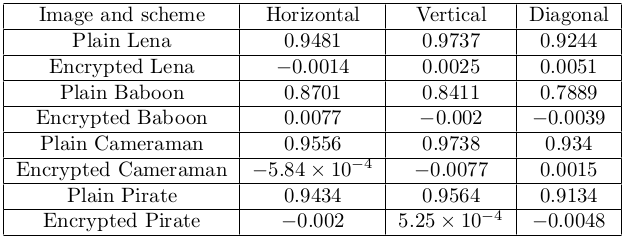
Table from the paper: An Image Encryption Algorithm Based on Chaotic Maps and Discrete Linear Chirp Transform
Table text:
Imageandscheme
Horizontal
Vertical
Diagonal
PlainLena
0.9481
0.9737
0.9244
EncryptedLena
− 0.0014
0.0025
0.0051
PlainBaboon
0.8701
0.8411
0.7889
EncryptedBaboon
0.0077
− 0.002
− 0.0039
PlainCameraman
0.9556
0.9738
0.934
EncryptedCameraman
− 5.84 × 10 − 4
− 0.0077
0.0015
PlainPirate
0.9434
0.9564
0.9134
EncryptedPirate
− 0.002
5.25 × 10 − 4
− 0.0048